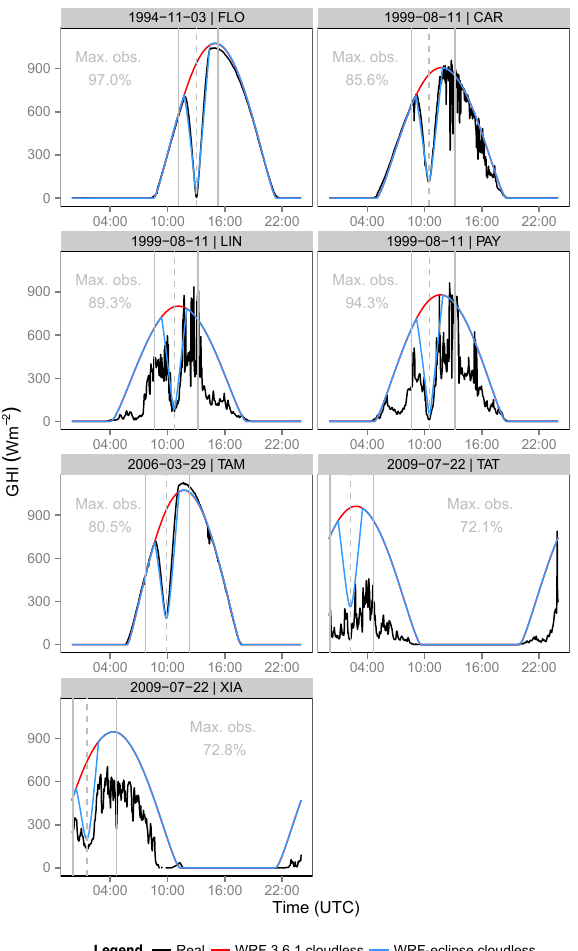
Figure 3. GHI outcomes for each episode and site. Each total solar eclipse event is labeled with the date. Plots show real measurements (in black), the control simulation (red) and the new implementation (blue). The first and second vertical gray solid lines indicate the time of FCTD and LCTD, respectively. The dashed vertical gray line shows the time of maximum obscuration. All results are ex- pressed with 1min time